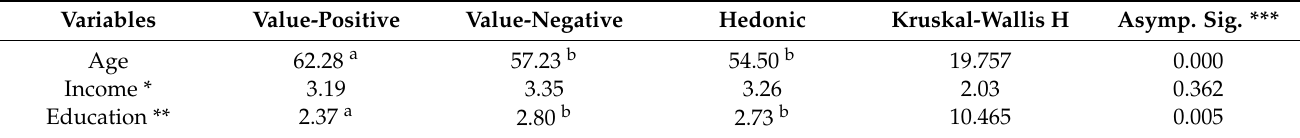
Table 6. Demographic variables by